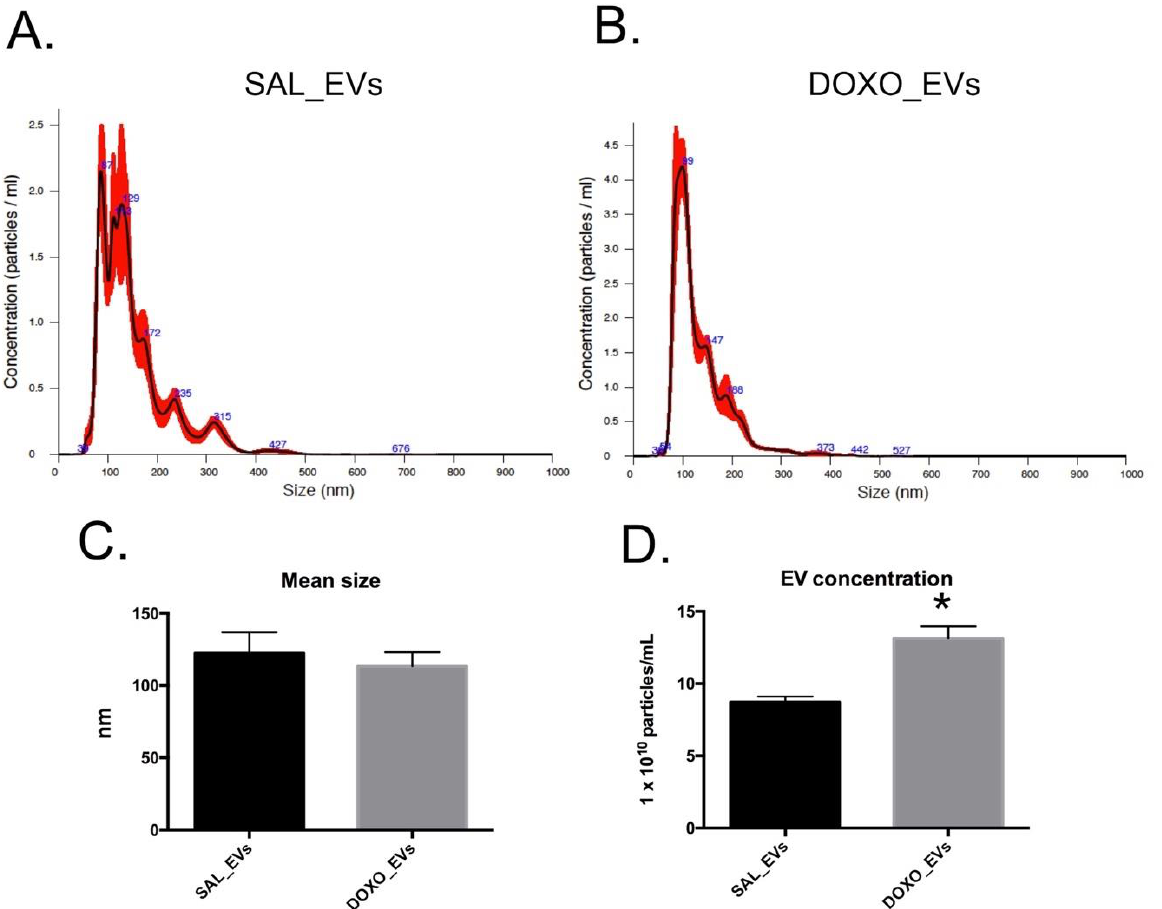
Figure 3. Representative graphs of size distributions of SAL_EVs ( A ) and DOXO_EVs ( B ) size distribution. Blue line represents the averaged data, whereas red line represents the SE. The mean size ± SE of SAL_EVs and DOXO_EVs ( C )The average EV concentration ± SE of SAL_EVs ( n = 5) and DOXO_EVs ( n = 5) ( D ). * p < 0.05.